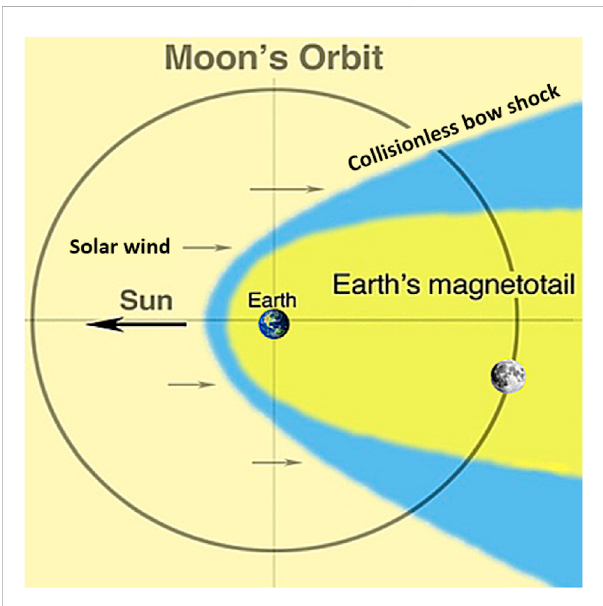
FIGURE 1 Moon ’ s orbit with respect to the Earth ’ s magnetosphere. Earth ’ s and Moon ’ s sizes are not on scale. (Adapted from: Tim Stubbs/ University of